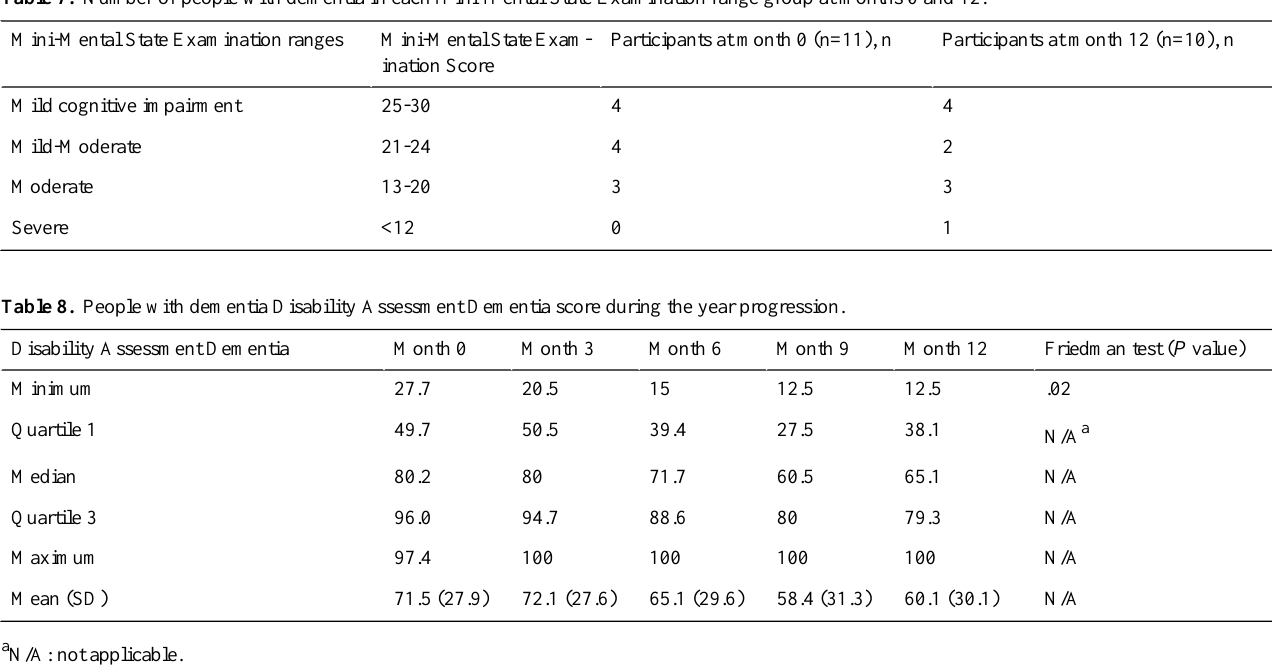
Table 7. Number of people with dementia in each Mini-Mental State Examination range group at months 0 and 12.